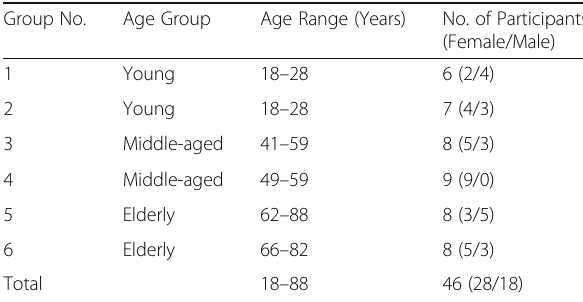
Table 1 Composition of the six focus groups Group No.